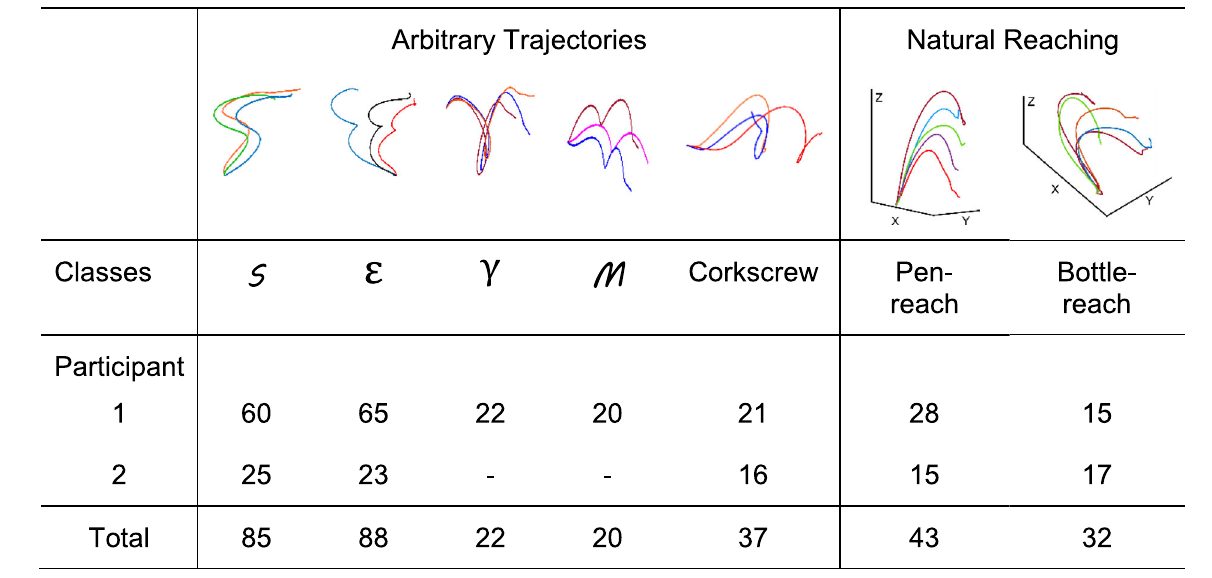
Table 1 Number of valid 2D and 3D arm trajectories from two participants with tetraplegia, used for training and testing machine learning algorithms. The trajectories are further categorized into arbitrary and natural reaching trajectories in 2D and 3D